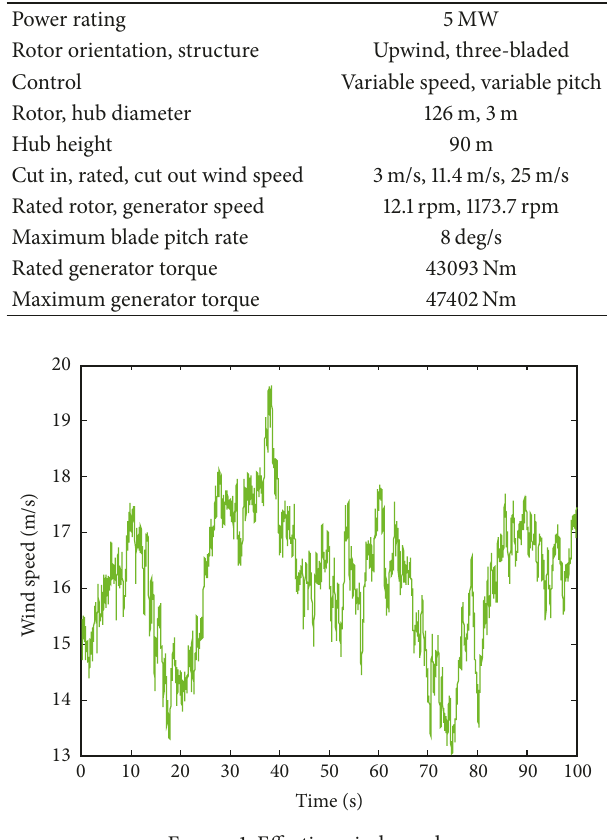
Figure 1: Effective wind